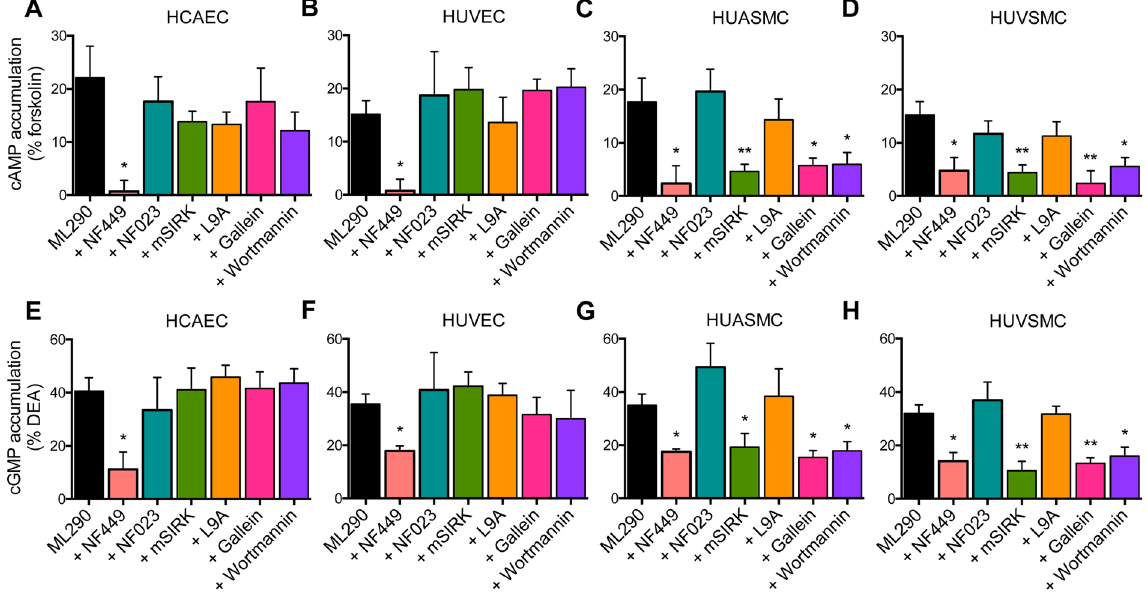
Figure 5. The role of G proteins, βγ subunits and PI3-kinase in ML290-mediated cAMP and cGMP accumulation in human primary vascular cells. ML290 (10 μ M, 30 min) increased cAMP accumulation in HCAECs (( A ) n = 5), HUVECs (( B ) n = 8), HUASMCs (( C ) n = 8) and HUVSMCs (( D ) n = 4). Treatment with the G α s inhibitor NF449 (10 μ M, 30 min) of HCAECs (( A ) n = 3) and HUVECs (( B ) n = 4) abolished ML290-mediated cAMP accumulation (30 min) whereas in HUASMCs (( C ) n = 4) and HUVSMCs (( D ) n = 4) it reduced the maximum cAMP response. The G α i/G α OB inhibitor NF023 (10 μ M, 30 min) in HCAECs (( A ) n = 4) and HUVECs (( B ) n = 4), HUASMCs (( C ) n = 4) and HUVSMCs (( D ) n = 4) had no effect on ML290- mediated cAMP accumulation. Pre-treatment of HCAECs (( A ) n = 3) and HUVECs (( B ) n = 3) with the G βγ inhibitors mSIRK (5 μ M, 30 min) and gallein (50 μ M, 45 min) and the PI3-kinase inhibitor Wortmannin (100 nM, 30 min) had no effect on ML290-mediated cAMP accumulation whereas pre-treatment of HUASMCs (( C ) n = 3) or HUVSMCs (( D ) n = 3) with both G βγ inhibitors and the PI3-kinase inhibitor reduced the maximum cAMP response to ML290. ML290 (10 μ M, 30 min) also increased cGMP accumulation in HCAECs (( E ) n = 3), HUVECs (( F ) n = 4), HUASMCs (( G ) n = 3) and HUVSMCs (( H ) n = 3). NF449 (10 μ M, 30 min) pre-treatment of HCAECs (( E ) n = 4); HUVECs (( F ) n = 3), HUASMCs (( G ) n = 6) and HUVSMCs (( H ) n = 4) reduced the maximum ML290-mediated cGMP response. Pretreatment with NF023 (10 μ M, 30 min) of HCAECs (( E ) n = 3), HUVECs (( F ) n = 3), HUASMCs (( G ) n = 4) and HUVSMCs (( H ) n = 4) had no effect on ML290-mediated cGMP accumulation. Pretreatment with the G βγ inhibitors mSIRK (5 μ M, 30 min) and gallein (50 μ M, 45 min) and the PI3-kinase inhibitor Wortmannin (100 nM, 30 min) had no effect on cGMP accumulation in HCAECs (( E ) n = 3) and HUVECs (( F ) n = 3) whereas in HUASMCs (( G ) n = 5) and HUVSMCs (( H ) n = 4), it reduced the maximum response. Pre-treatment of HUASMCs (( C , G ) n = 4–11) and HUVSMCs (( D , H ) n = 4–5) with mSIRK control peptide L9A (5 μ M, 30 min) had no significant effect on ML290-mediated cAMP or cGMP accumulation. Statistical significance was assessed using a one-way ANOVA with a Dunnet’s post-hoc test compared to ML290 alone: ** p < 0.01 and * p < 0.05. Data shown are mean ± SEM of ‘n’ independent